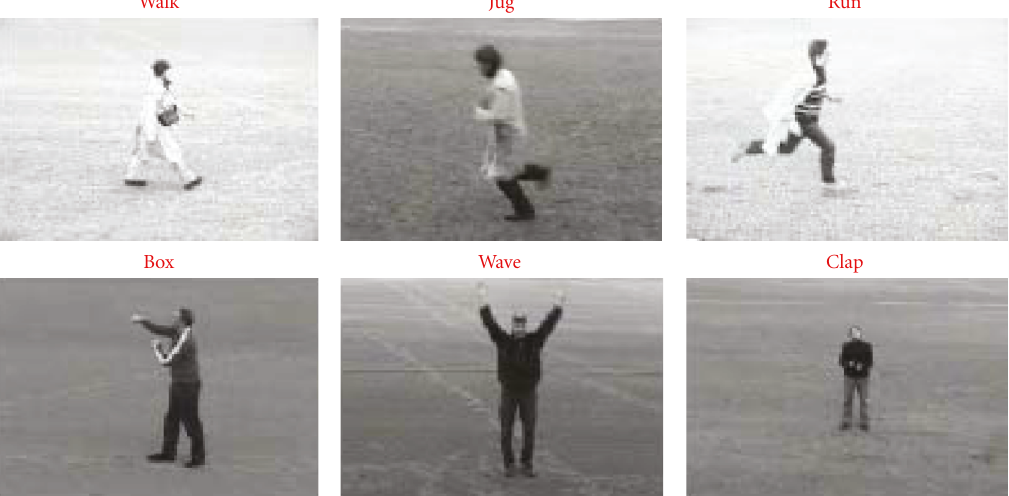
Figure 5: Example sequences from the KTH action dataset.